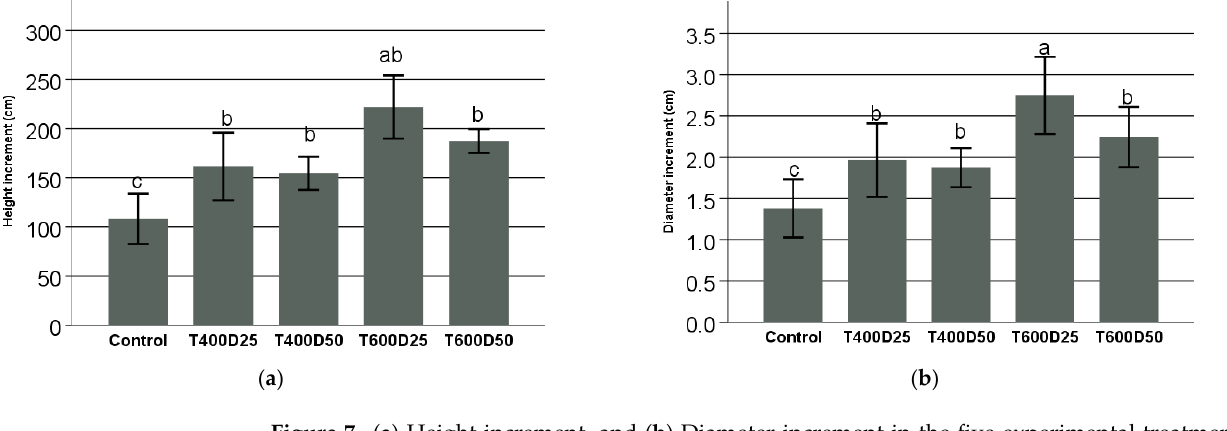
Figure 7. ( a ) Height increment, and ( b ) Diameter increment in the five experimental treatments: dosage 0 t ha − 1 (control), dosage 25 t ha − 1 at 400 °C (D25T400), a dosage of 50 t ha − 1 at a temperature of 400 °C (D50T400), dosage 25 t ha − 1 at 600 °C (D25T600), and a dosage of 50 t ha − 1 at a temperature of 600 °C (D50T600) after six months planted in the field. Different letters above the bars indicate statistically significant differences between the sampling times within the same treatment ( p ≤ 0.05). Vertical bars represent the standard error of the mean.